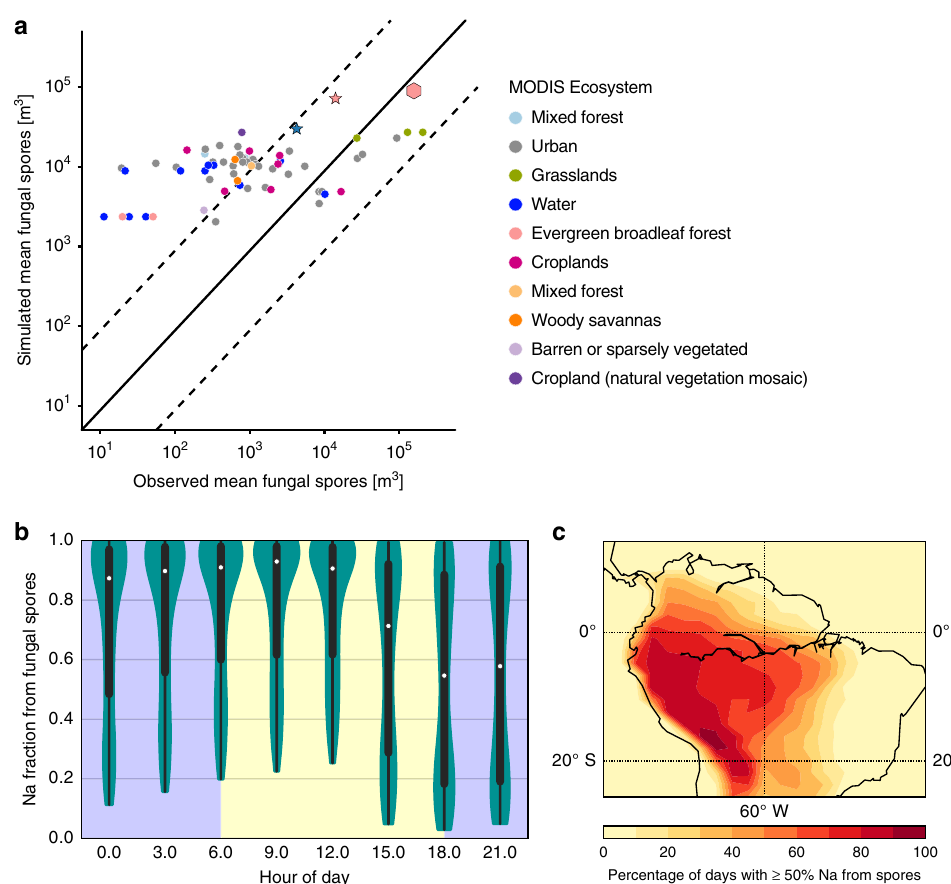
Fig. 3 Simulation of sodium contribution from biological particles to total sodium budget in the Amazon area. a Comparison of annual-mean model- simulated fungal spore concentrations with previously published observed concentrations at various locations. All model-simulated values are annual means of fungal concentrations simulated using nudged meteorology. Observations are averages over the measurement period for each campaign (mostly between 2 months and 3 years), as previously reported in the literature (a full reference list for the observed spore counts is provided in Supplementary Table 2, together with a map of their geographic locations Supplementary Fig. 8). Dotted lines represent an over- or underestimate of a factor of 10 (10:1 and 1:10, respectively). The pink hexagonal point represents the measured fungal spore concentration in this study, compared with the mean simulated spore concentration from the same time period (26 Jan to 8 Feb 2015). The stars indicate points from literature measurements from tropical rainforests. b Distribution of the simulated daily mean sodium fraction contributed by fungal spores during the wet season (Jan – Jun, 2015). Simulated values are obtained from the model grid point nearest to the ZF2 tower (2.84° S 60.0° W), in the model ’ s lowest (near-surface) layer. The violin plot displays the kernel density estimation of the underlying distribution, along with the median (white dots), 25th – 75th percentile (thick vertical bar), and range (thin vertical line). The shaded regions of the plot represent nighttime (blue shading; 1800 – 0600) and daytime (yellow shading, 0600 – 1800). c Percentage of days when fungal spores contributed at least 50% of estimated total sodium during the wet season, assuming that 70% of fungal spores are sodium rich, containing 13% sodium by mass, and sea salt aerosol is composed of 30% Na by mass. Results for the dry season are shown in Supplementary Fig.